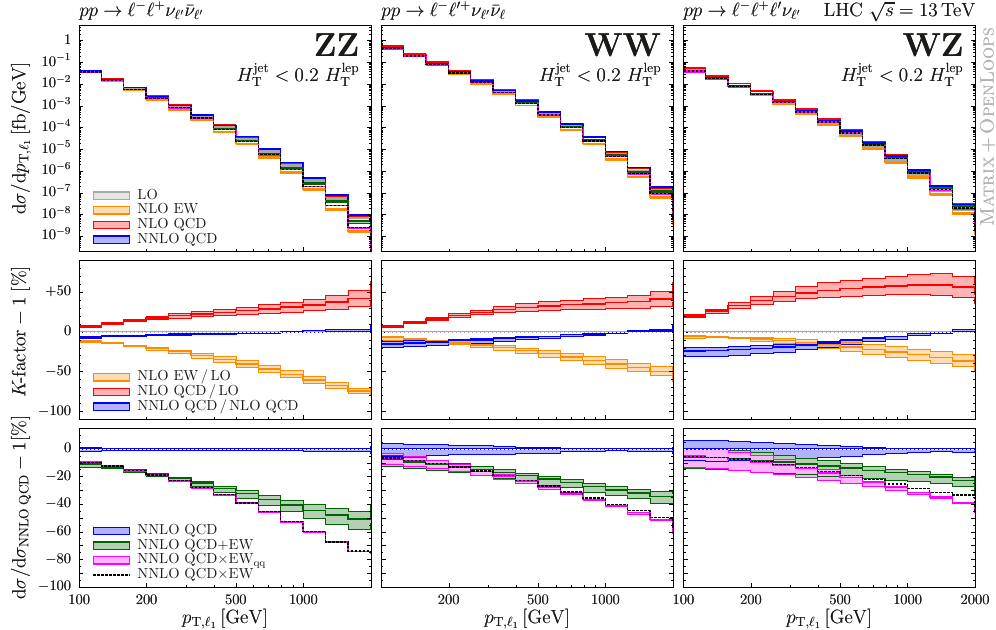
Figure 14 . Distribution in the transverse momentum of the hardest charged lepton for the processes (3.1){(3.3) at 13 TeV. Same plots as in (cid:12)gure 9, but in addition to the baseline cuts also the jet veto (3.16) is applied.